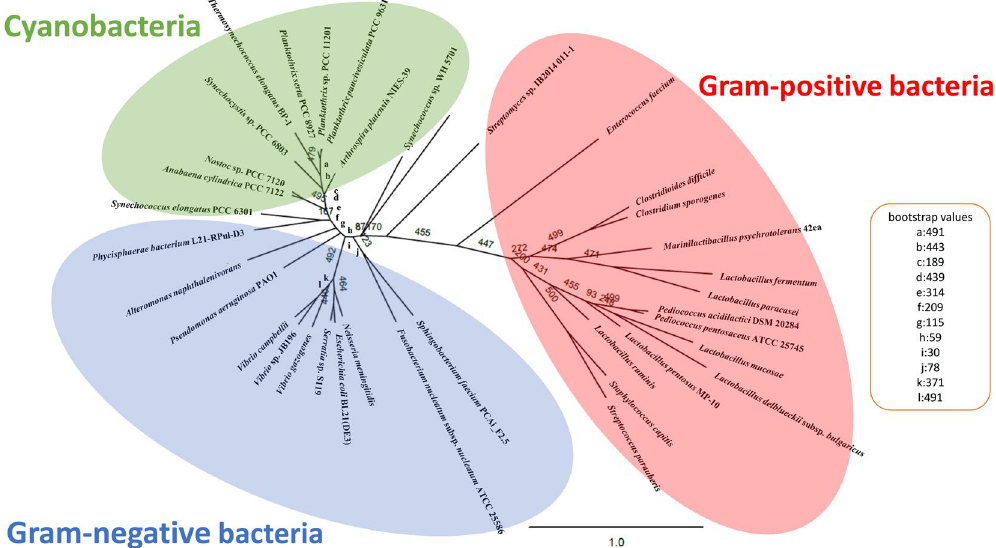
Figure 2. Phylogenetic analysis of the Ddhs from cyanobacteria, Gram-negative bacteria, and Gram-positive bacteria. Protein sequences and accession numbers were obtained from GenBank, followed by alignment using CLC Sequence Viewer software. A maximum-likelihood tree based on 262 conserved amino acids was generated using PHYML (http://www.atgc-montpellier.fr/phyml/). The bootstrap values were obtained from 500